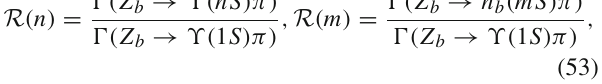
(cid:3) π vs. Borel parameter M 2 (left panel), and continuum threshold s 0 (right panel) b h b